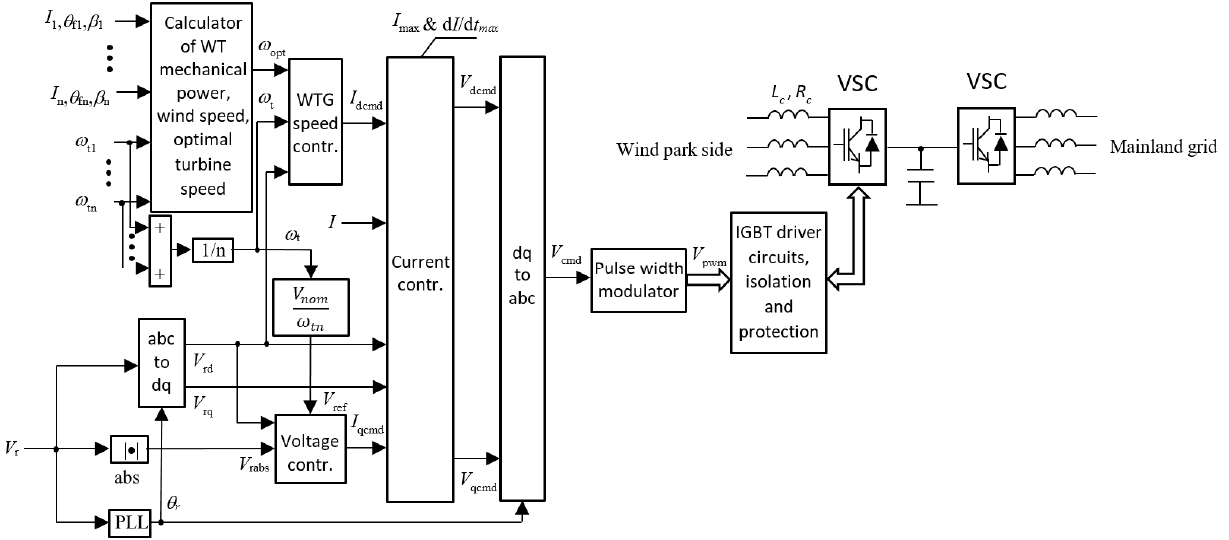
Figure 2. B2B converter control system (wind park side).